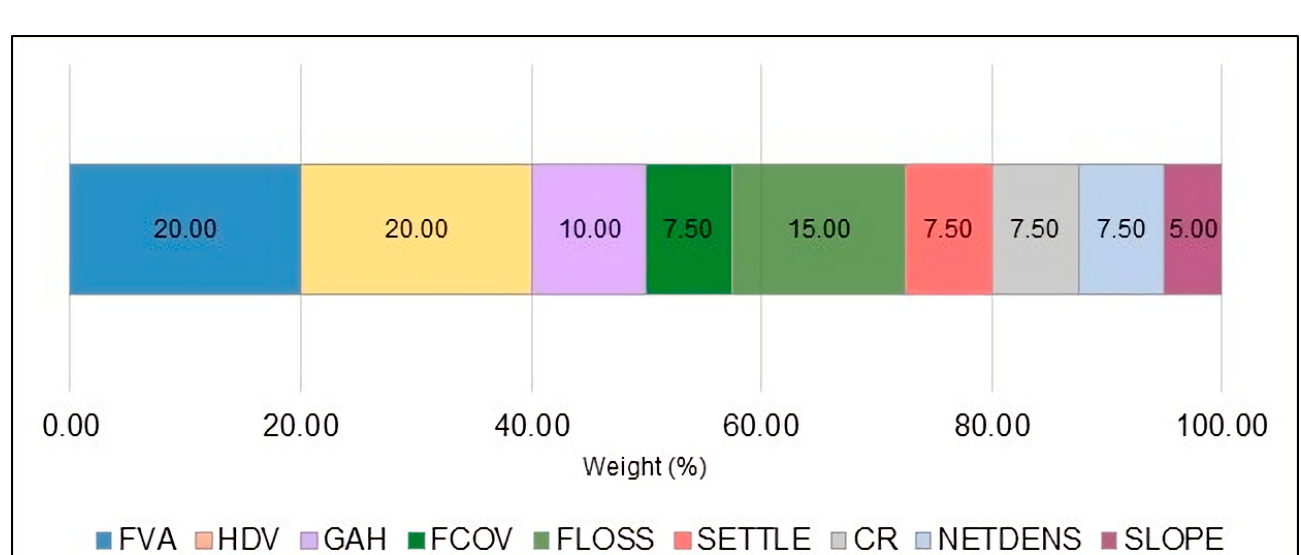
Figure 7. The weights of the hydrological, land use, and constant factors.